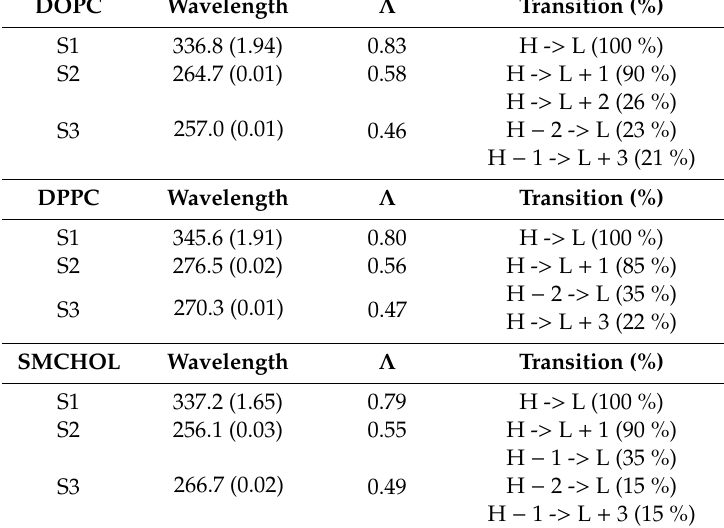
Table A2. Absorption properties for the first three excited states of the DPH probe embedded in the di ff erent membranes. Oscillator strength is reported in parentheses; all energy values are in nm a .